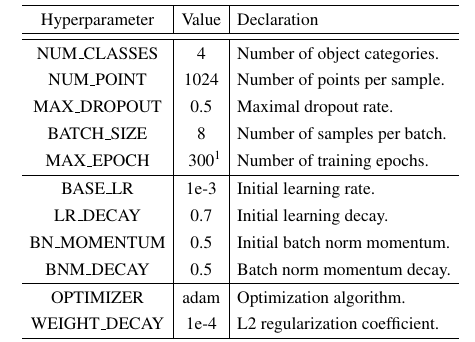
Figure 5. Confusion matrices on the test dataset using only geometry information.